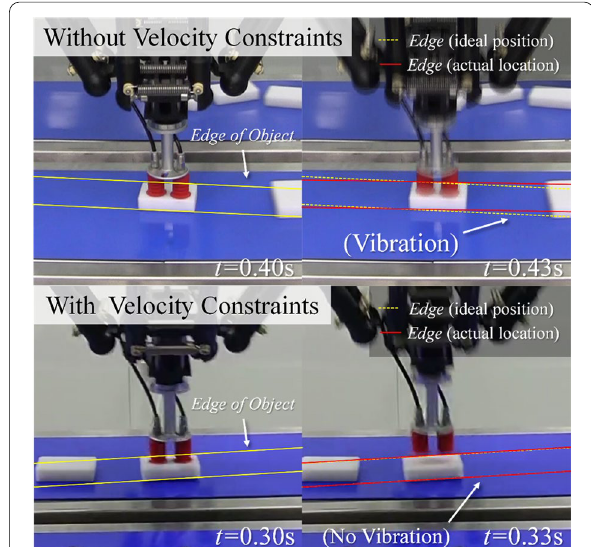
Figure 14 Pick-and-place